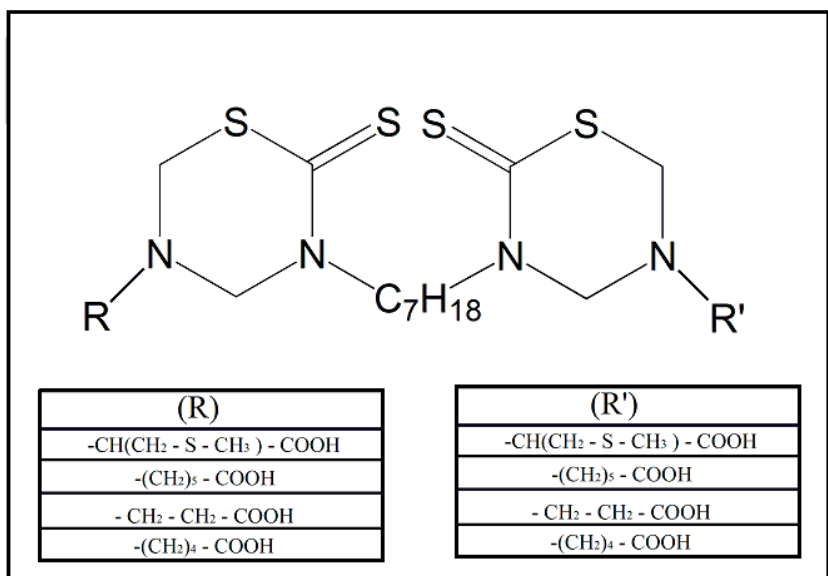
Figure 7. Synthetic dithiocarbamate derivatives bound to thiadiazone used as potential anti- Trypanosoma brucei rhodesiense drugs. The basic structures may receive different chemical substituents (R and R‘) that could influence the antiparasitic activity of the new synthesized compounds [62].